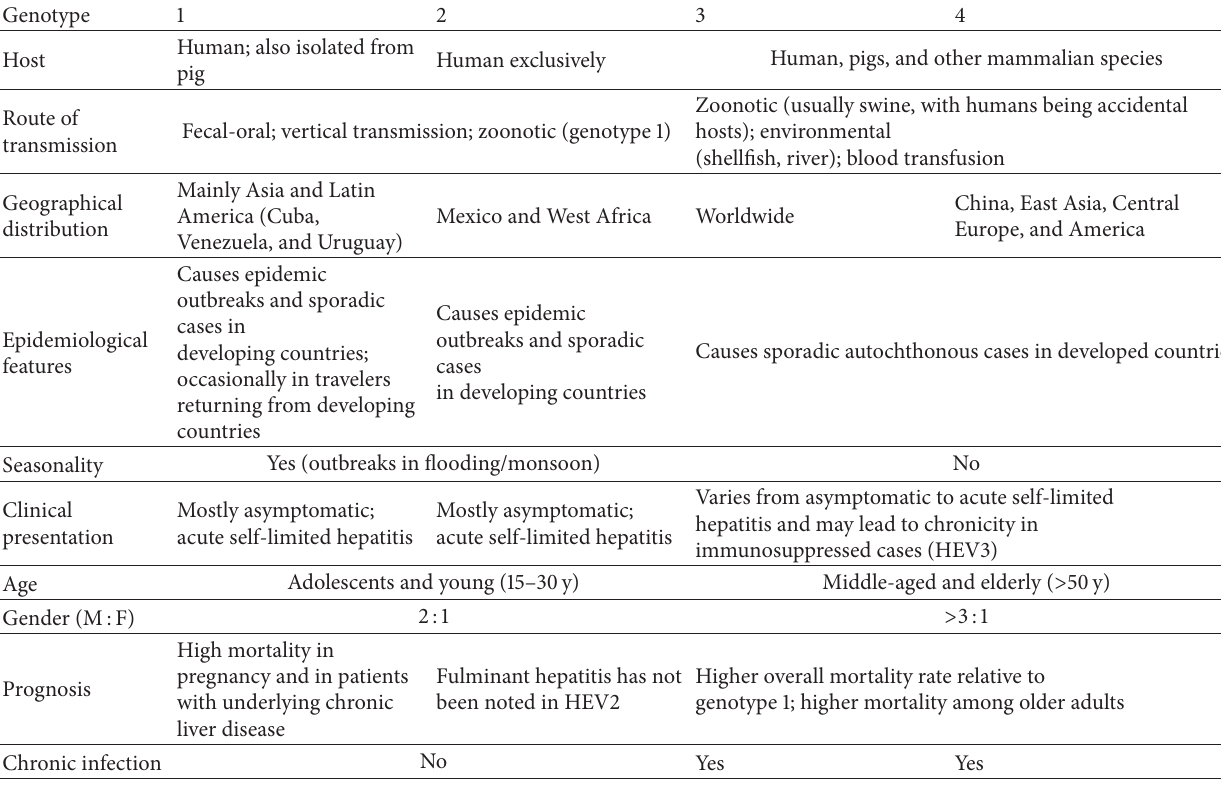
Table 2: Individuals at higher risk of acute liver failure from HEV infection [1, 3, 6, 7, 12, 22–24]. Pregnant women Individuals with preexisting liver disease Hepatitis B virus carriers Individuals with drug induced liver injuries Active alcohol